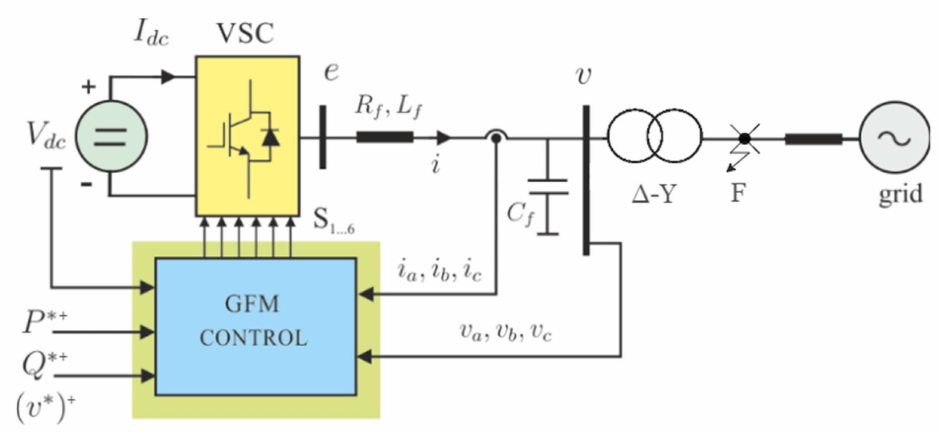
Figure 1. System description of a GFM connected to a